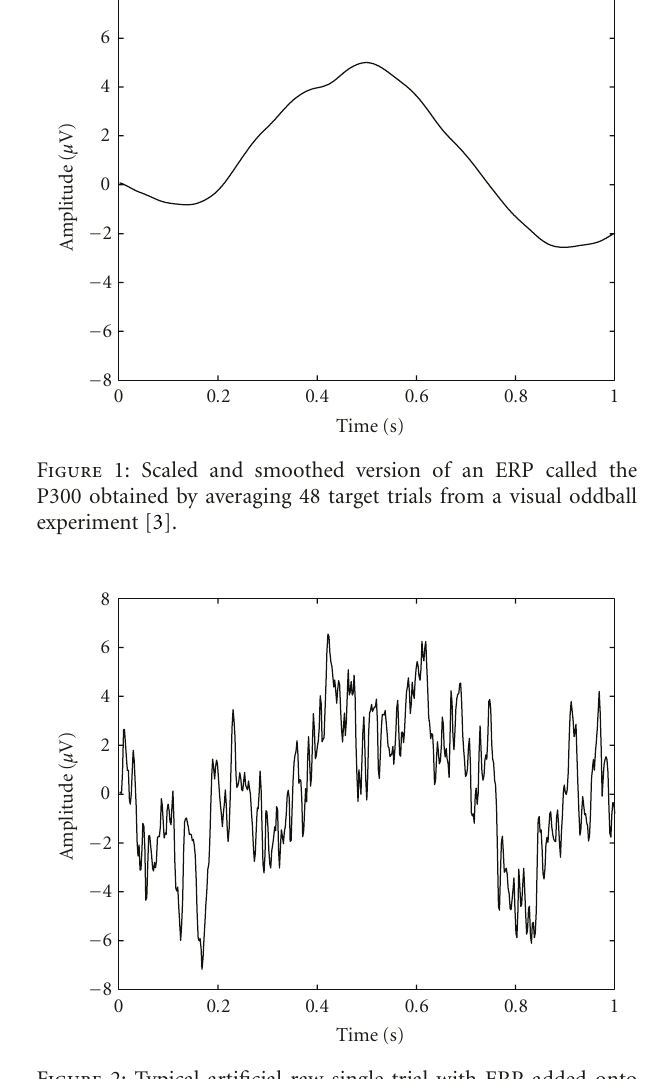
Figure 2: Typical artificial raw single-trial with ERP added onto background EEG. SNR = 1. The P300 ERP is hardly